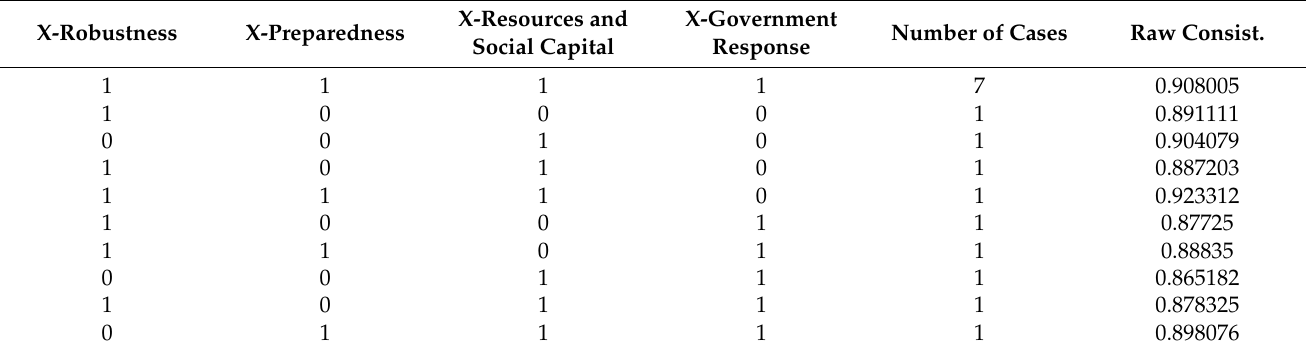
Table 7. Truth table